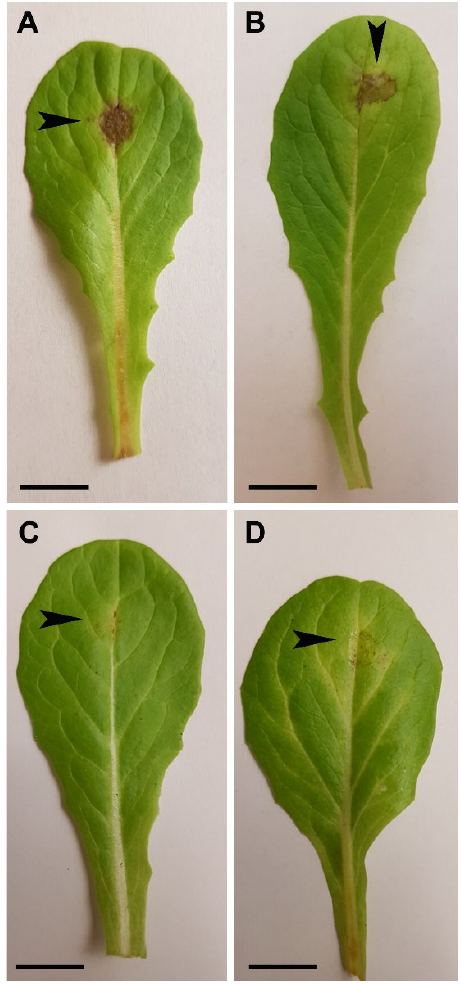
Figure 4. Infection symptoms of B. cinerea B05.10 on leaves of Lactuca sativa cv. Romana at 5 dpi. ( A ) Leaves were treated with water + TE (Ctrl), ( B ) GFP ‐ dsRNA, ( C ) BcBmp1 ‐ dsRNA, or ( D ) BcPls1 ‐ dsRNA and were then artificially inoculated with a conidial suspension (5 × 10 2 spores) of the pathogen. Scale bars = ( A ): 1.19 cm; ( B ): 1.12 cm; ( C ): 1.16 cm; and ( D ): 1.14 cm.